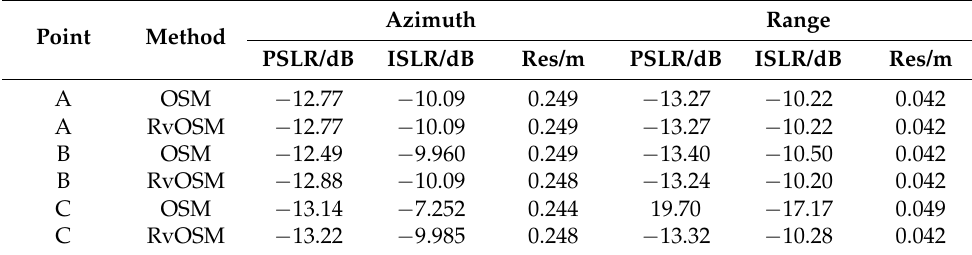
Table 3. Point Target Analysis of One-Step MoCo with Signal s 3 .